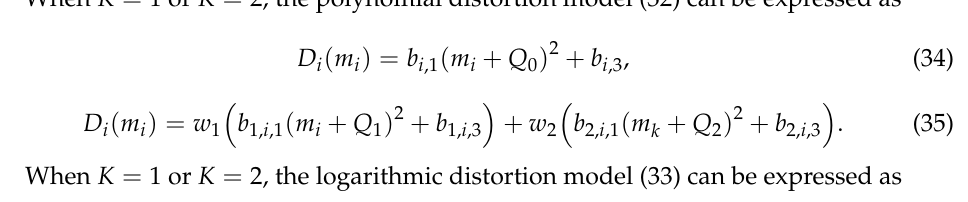
c . Figure 9. The probabilistic histograms of parameters c 1 and c 2 : ( a ) c 1 ; ( b ) c 2 2